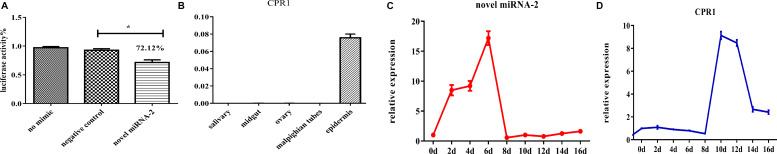
The target gene identification and expression patterns analysis of novel miRNA-2 and CPR1. (A) Dual luciferase reporter assay of CPR1. The data indicate the percent activity and are presented as the means ± SEMs from triplicate samples. The percentages are shown. *P < 0.05. (B) The relative expression levels of CPR1 in salivary gland, midgut, ovarian, Malpighian tubules, and epidermal tissues were analyzed by qRT-PCR. (C) The relative expression level of novel miRNA-2 in the epidermis was analyzed every two days (D: day) during the molting process of nymphs by qRT-PCR. (D) The relative expression level of CPR1 in the epidermis was analyzed every two days (D: day) during the molting process of nymphs by qRT-PCR. All the data are presented as the results from three biological replicates, each of which included three technical replicates, and are presented as the means ± SEMs.